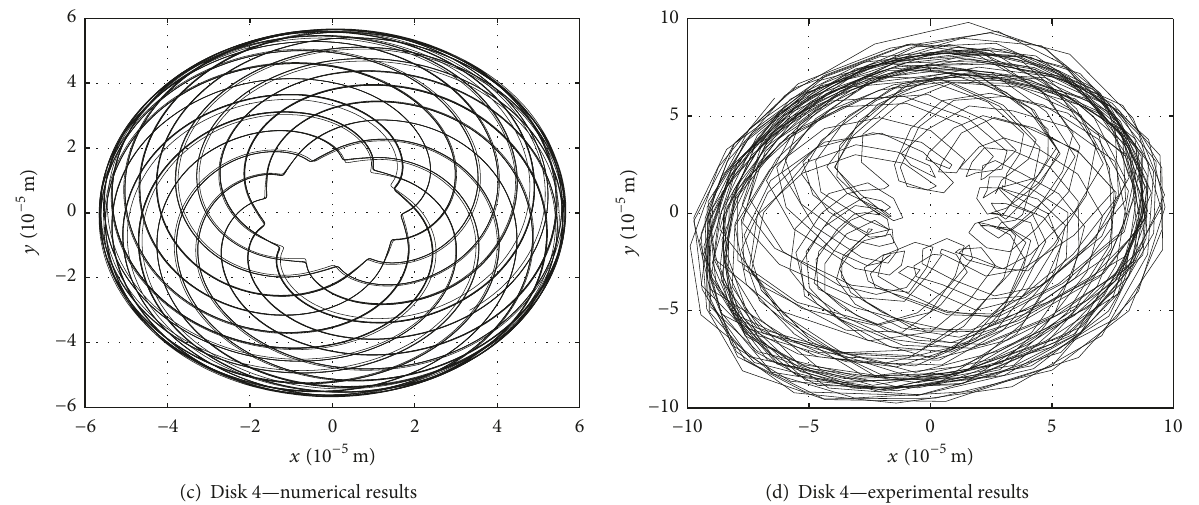
Figure 22: Orbit of disk 2 and disk 4 with 𝜔 1 = 170 rad / s and 𝜆 = 1.65